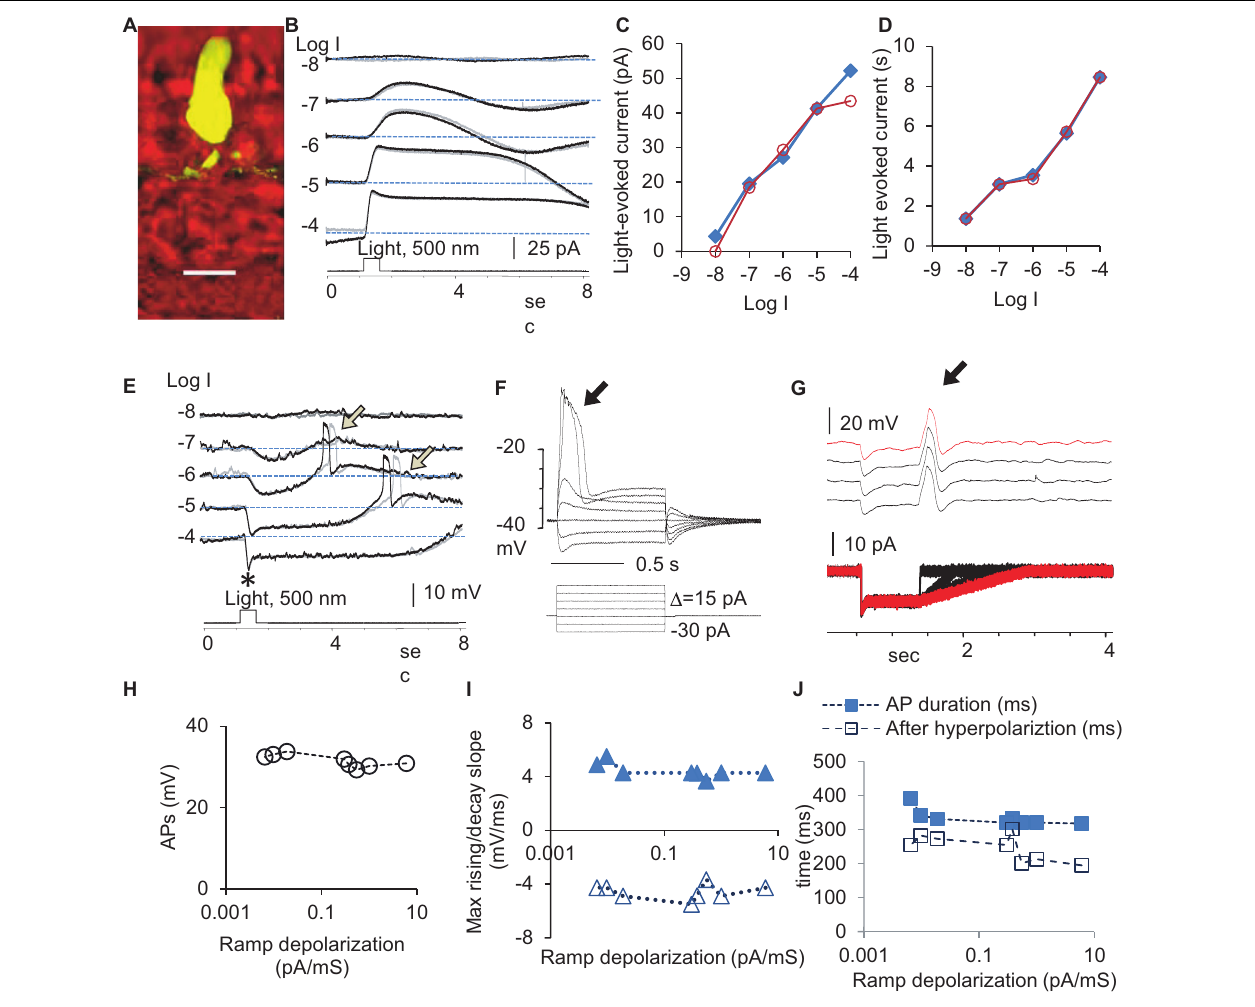
FIGURE 1 | Light- and electric stimulus-evoked graded and action potentials (APs) in dark-adapted rods. Rods were recorded under whole-cell voltage- ( B , Vh = –40 mV) and current-clamp modes (E) . (A) A recorded rod was filled with Lucifer yellow, and the scale bar is 20 µ m. (B) Rods respond to 0.5 s light steps of various light intensities (in log unit, log I) generally with the outward current/hyperpolarization, which shows a progressively larger amplitude (C) and longer duration (D) with the increase of light intensity. (E) Light also evokes APs (arrow) after the light offset. The black and gray traces illustrate two trials recorded under the same light intensity (B,E) . The delay of APs evoked by the light offset shows some variation. Asterisk: a brief “nose” appears upon the photopic light onset. (F–J) The leading edge of the supra-threshold square-wave depolarization (F) and the trailing edge of the hyperpolarization specially designed to simulate rod light response (G) both evoked action potentials (arrow) of a stable amplitude (H) , duration (J) , and the rising and decay slopes (I) , consistent with the “all-or-none” principle of APs. (F) The voltage-dependent activation of APs in a rod with a resting potential of –46 mV and the threshold of the AP at ∼ –36 mV. (G) The depolarizing ramp of various slopes at the end of the hyperpolarizing step of –15 pA, which mimics the rod Phase 3, elicits a single AP in rods (subthreshold stimuli are not presented). Vh-holding potential. The intensity of unattenuated [0 in log unit (log I)] 500 nm light from a halogen light source was 4.4 × 10 5 photons. µ m − 2 .s − 1